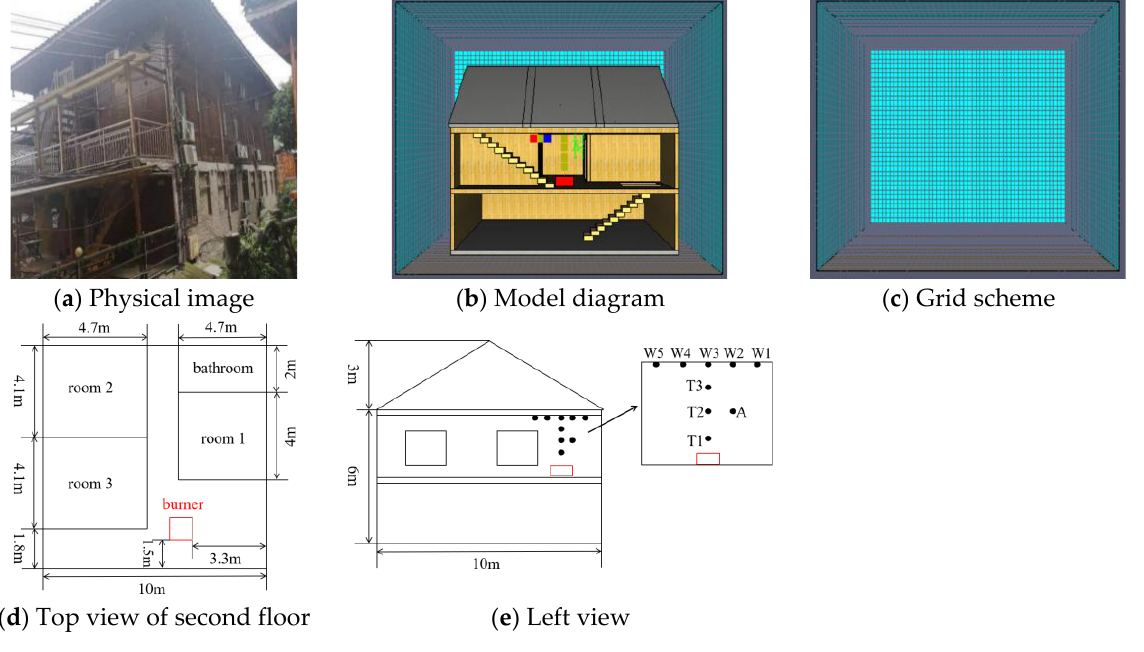
Figure 1. Model of a stilted building .